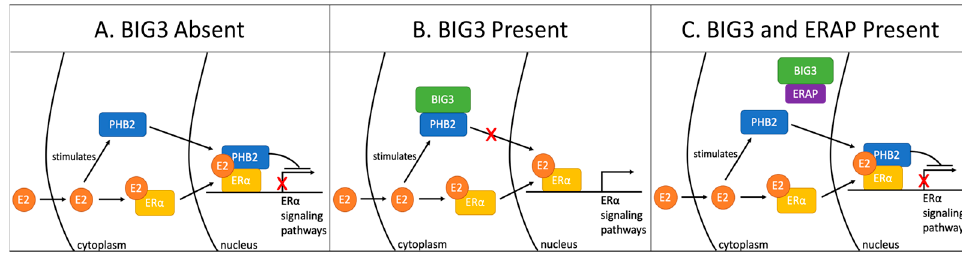
Figure 4. Interaction of PHB2, BIG3, and ERAP. ( A ) BIG3 Absent: E2 stimulates PHB2 to translocate into the nucleus and suppress the transcriptional activity of ER ⍺ . ( B ) BIG3 Present: BIG3 binds to PHB2 and inhibits its translocation into the nucleus, thereby preventing PHB2 inhibition of ER ⍺ transcriptional activity. ( C ) ERAP Present: ERAP competitively binds BIG3, thus freeing PHB2, allowing its translocation into the nucleus.